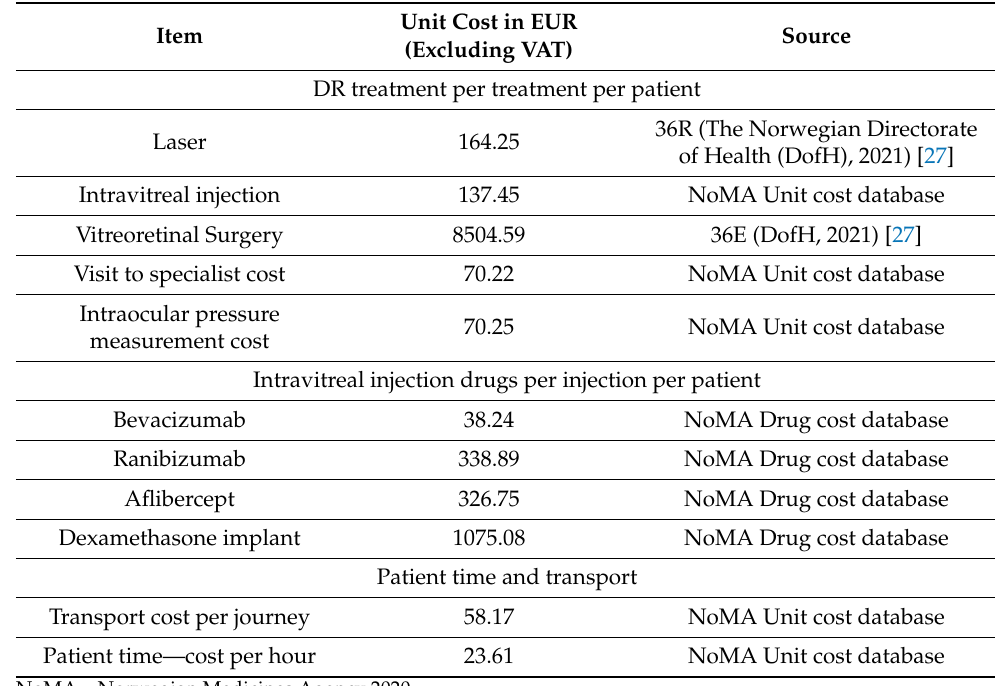
Table 1. Unit costs for diabetic retinopathy treatments in